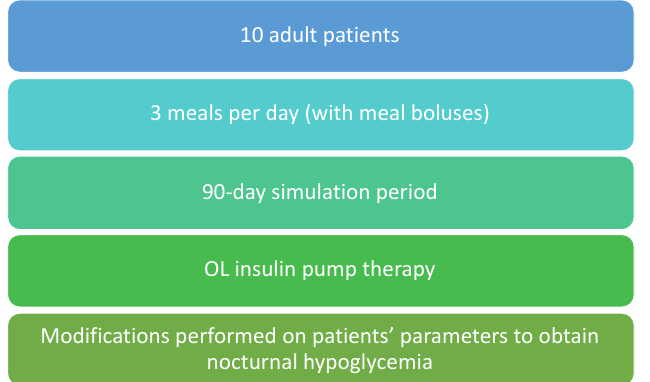
Figure 3. Summary of the parameters and implemented features in the UVA Padova simulator to validate the mitigation measures. Abbreviations: OL, open loop.